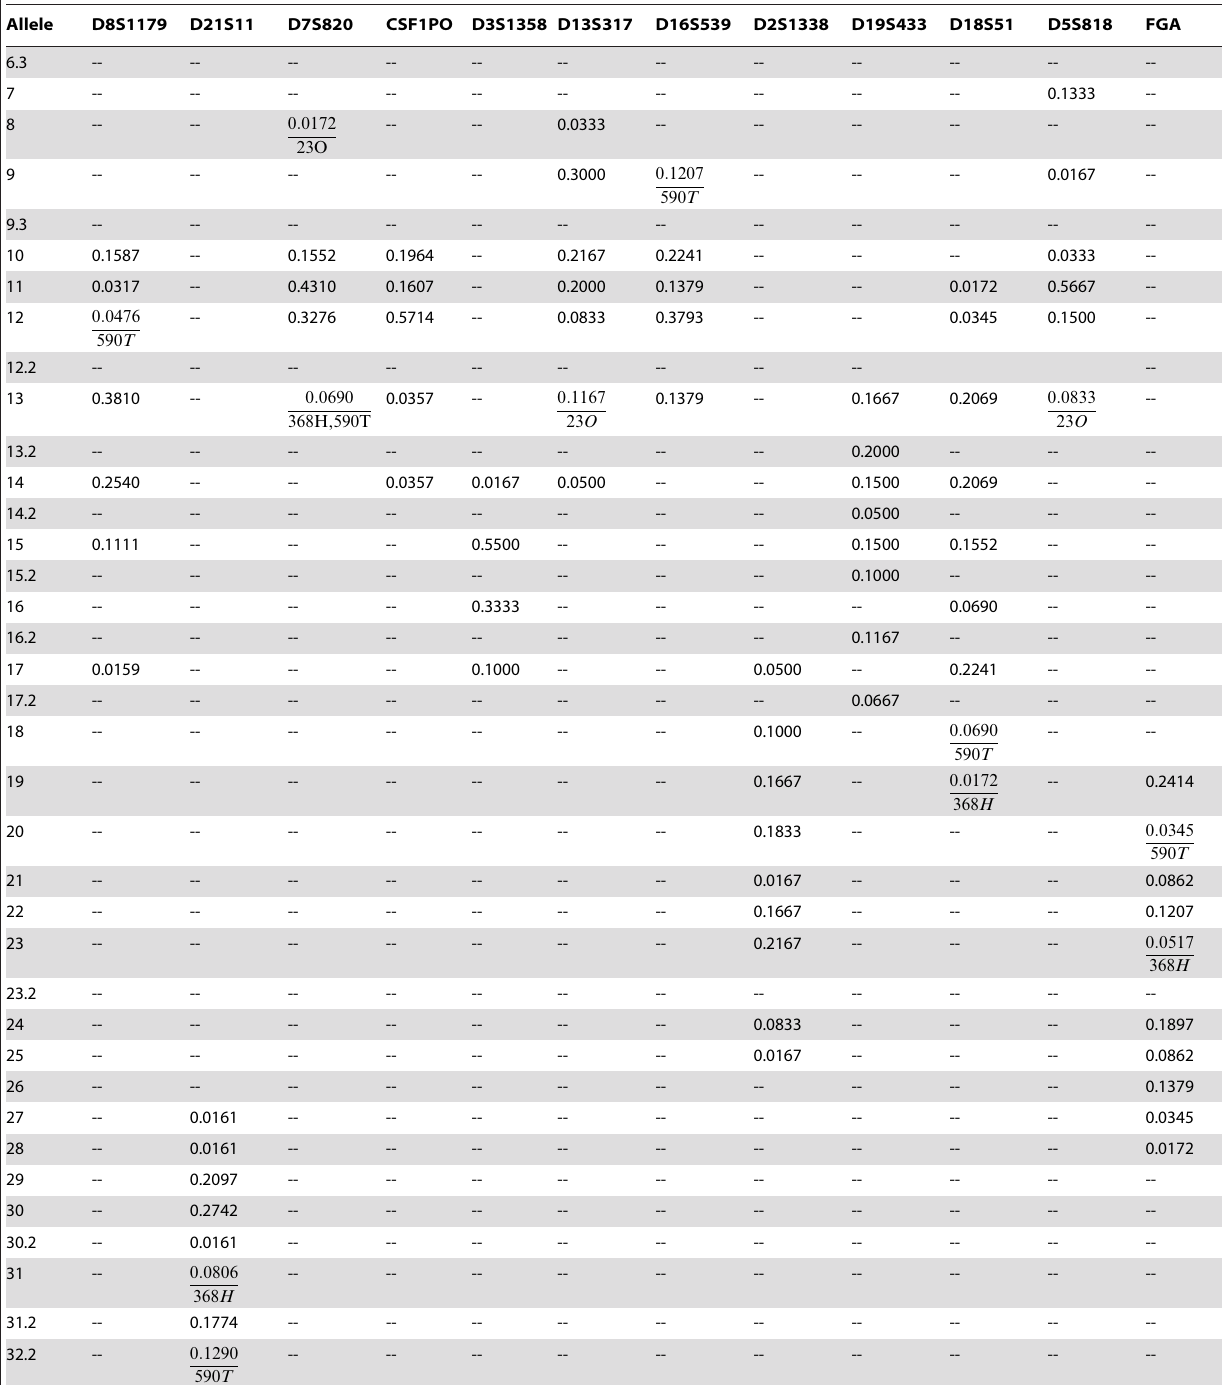
Table 3. Frequencies of STRs alleles in three Mexican Native